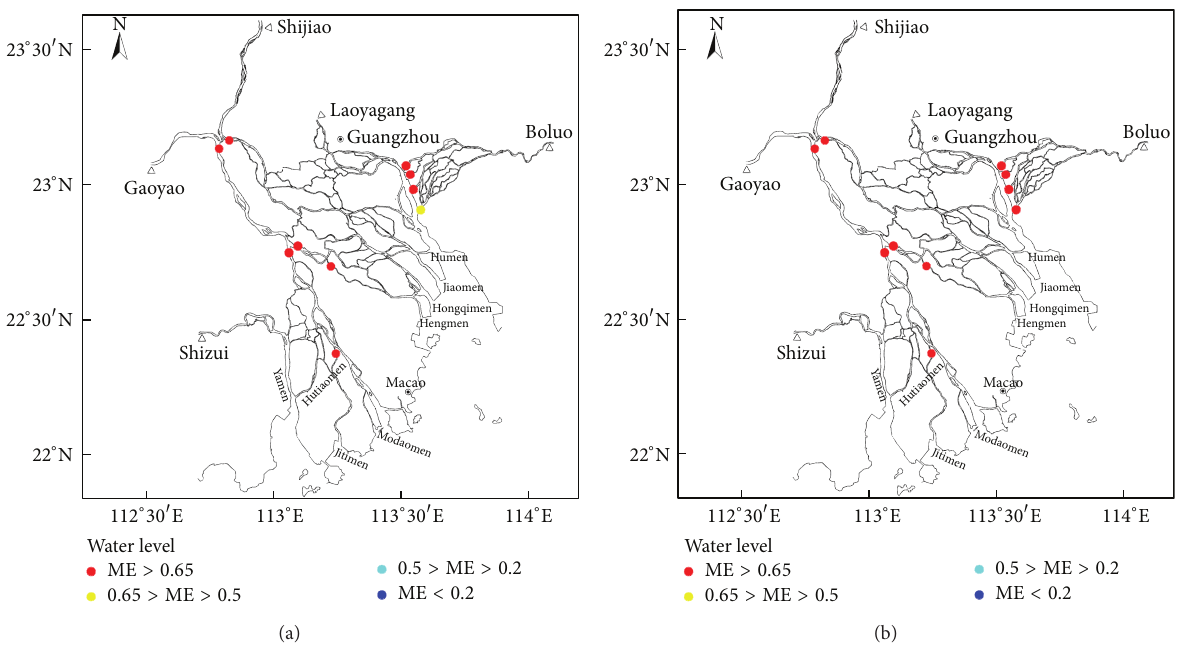
Figure 5: (a) The calibration of water levels from July 18 to July 19, 1998. (b) The validation of water levels from February 7 to February 16,